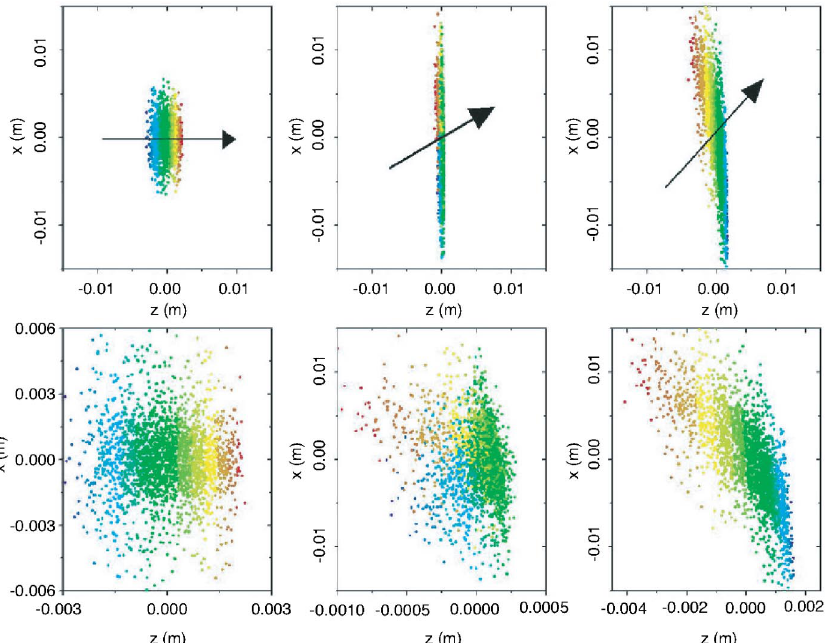
FIG. 17. (Color) Cartesian configuration space x - z projections for a beam accelerated 70 (cid:1) off crest in the PWT linac at three different locations along the Neptune beam line: before the dipole (first column), at the anomalous compression point 12 cm inside the dipole (second column), and after the crossover (third column). The top line has equal scale on x and z axes. An arrow shows the beam propagation direction. The bottom pictures are zoomed versions of the top ones with expanded axes. Particles with higher energy (blue) that were in the tail of the beam overcome the lower energy particles (red) in the